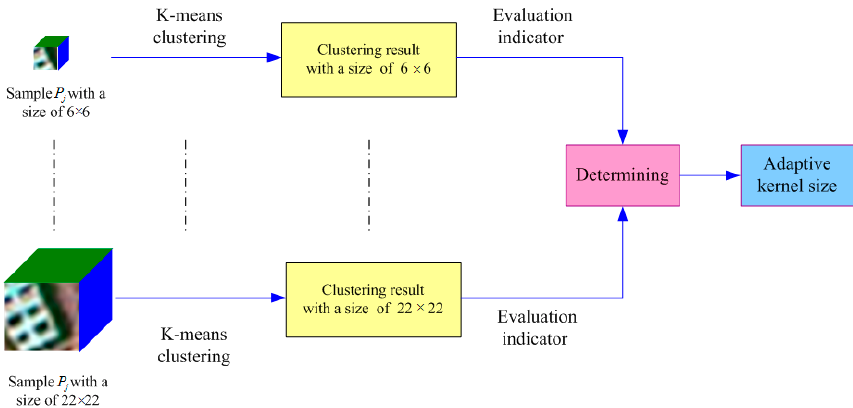
Figure 3. The flow chart of determining the adaptive size of the convolutional kernels.